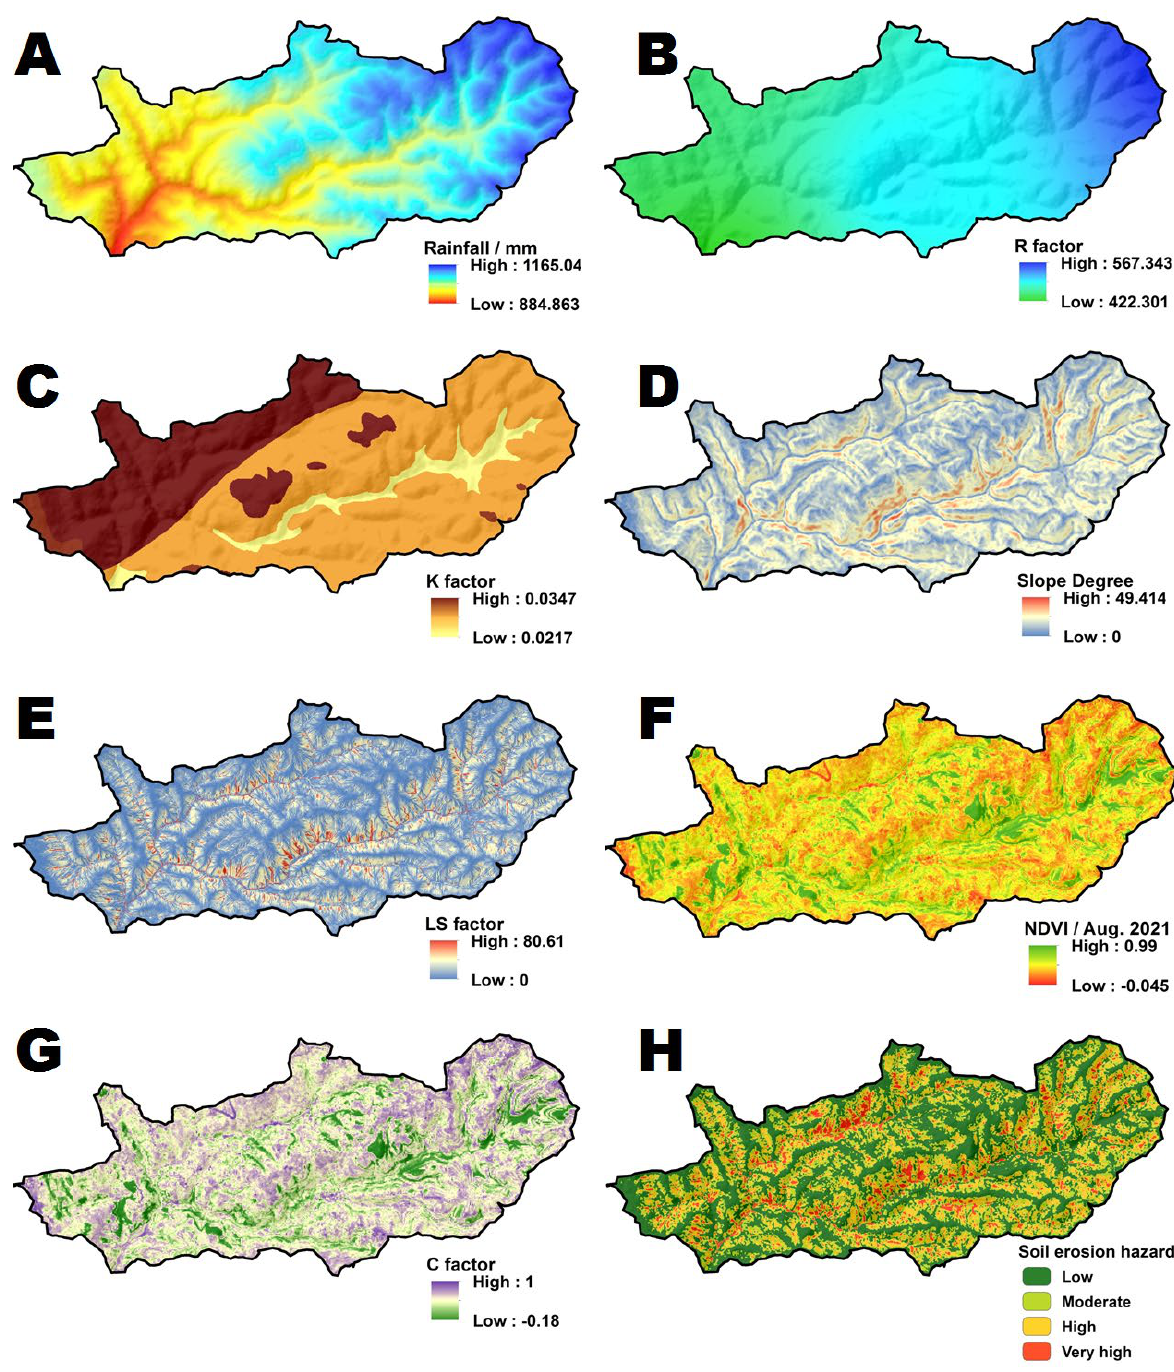
R K (B) (C) NDVI C (F) (G) ) factor , soil erodibility ( ) factor , slope ) , vegetation ( ) factor ,